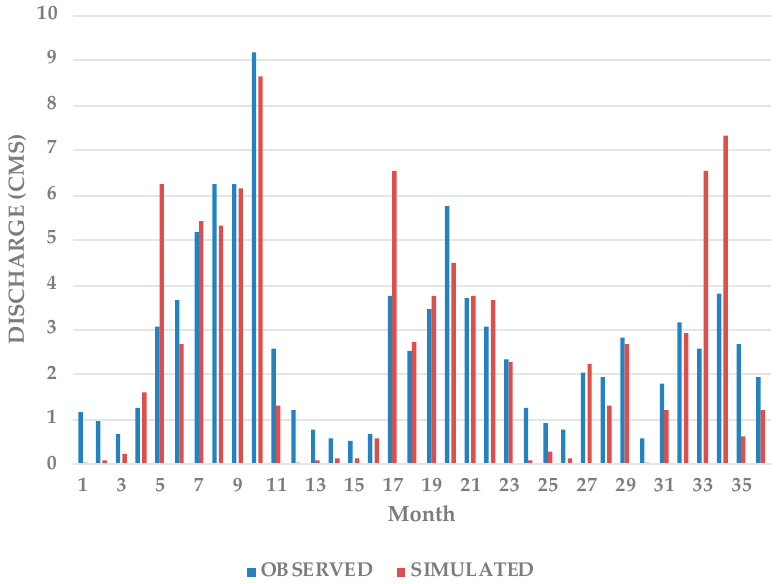
Figure 8. Thirty-six-month (2010–2012) cumulative streamflow from the Guanajibo Watershed: observed vs. GOES-PRWEB-estimated RO + DP.